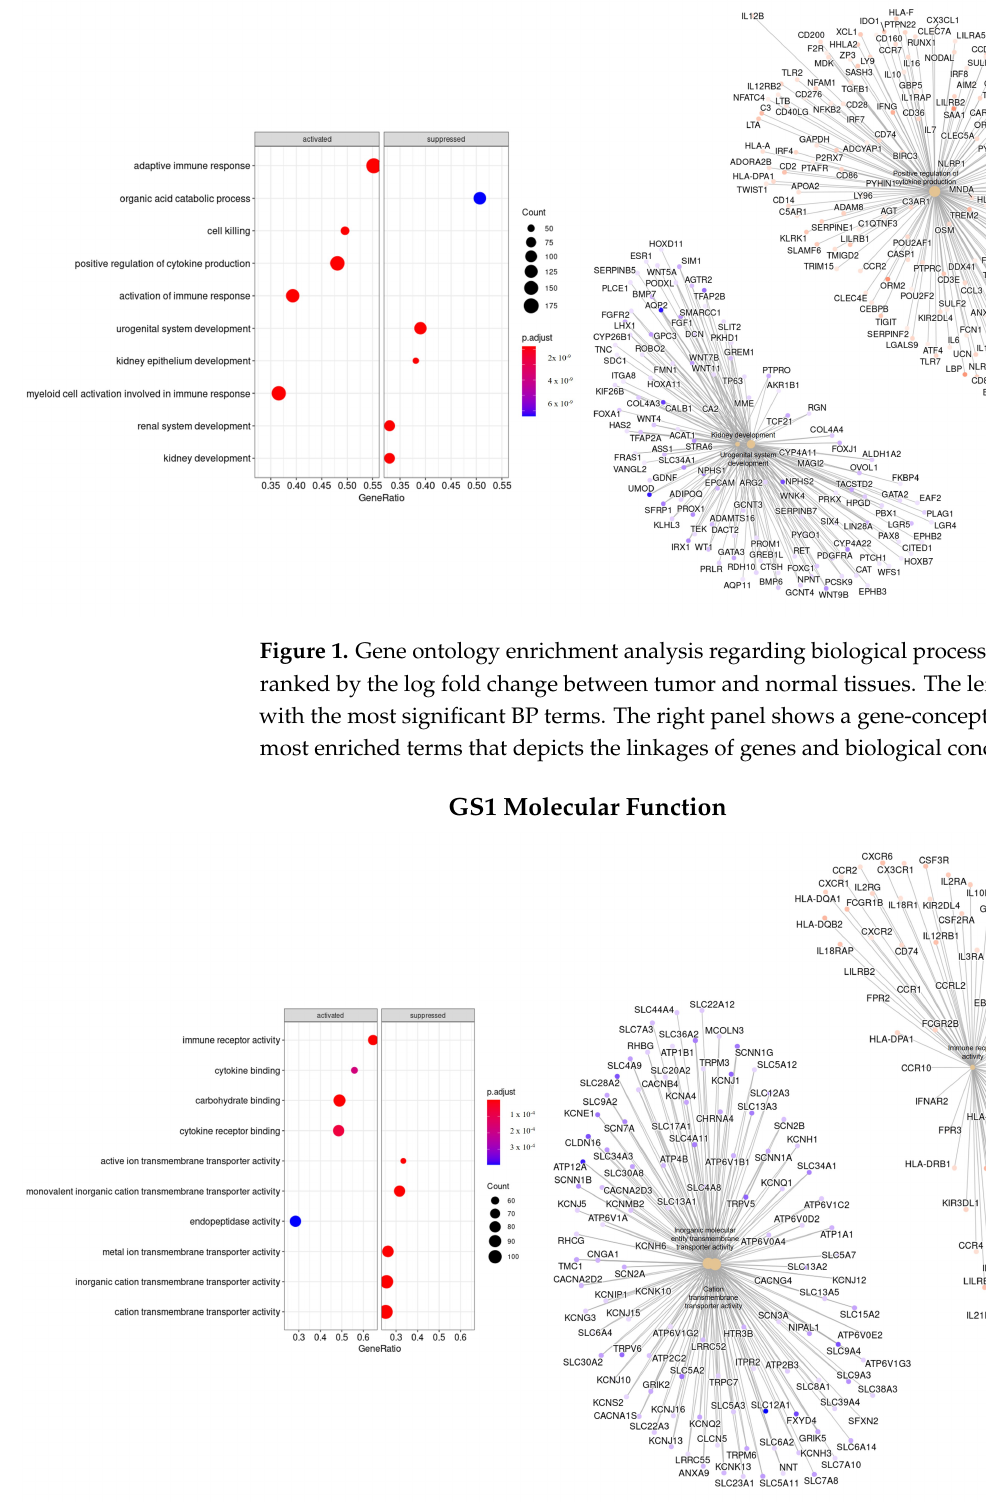
Figure 2. Gene ontology enrichment analysis regarding molecular function terms for a list of DEGs ranked by the log fold change between tumor and normal tissues. The left panel shows a dot chart with the most significant MF terms. The right panel shows a gene-concept network plot of the three most enriched terms that depicts the linkages of genes and biological concepts as a